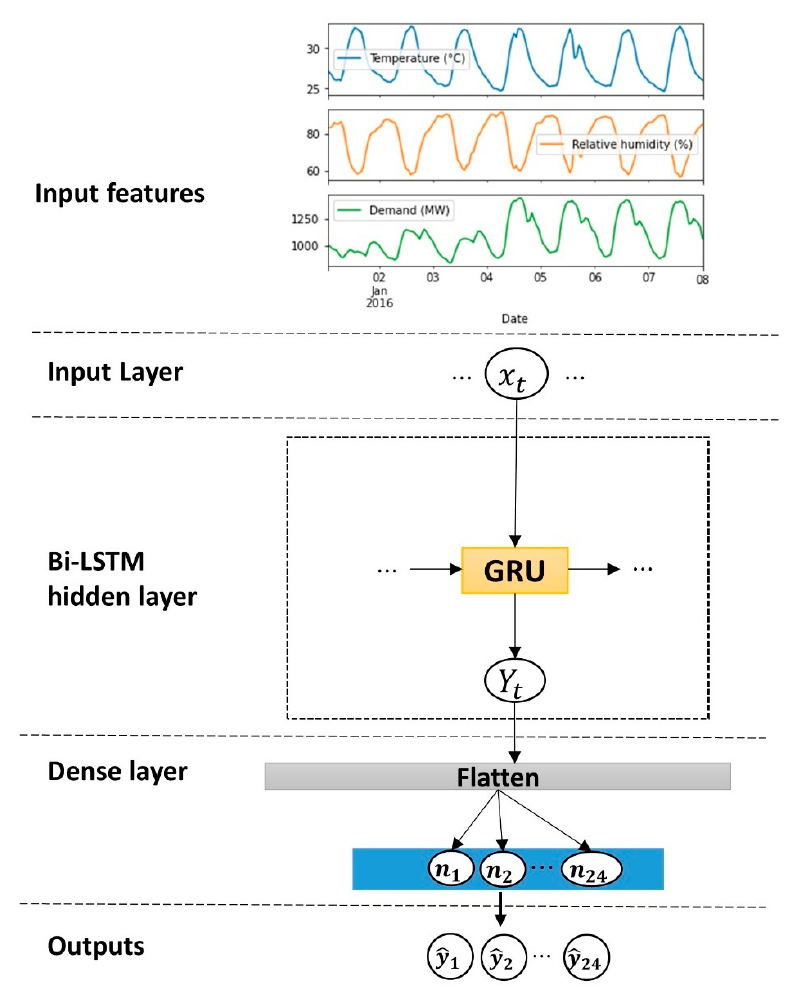
Figure 5. GRU architecture for predicting electricity demand.